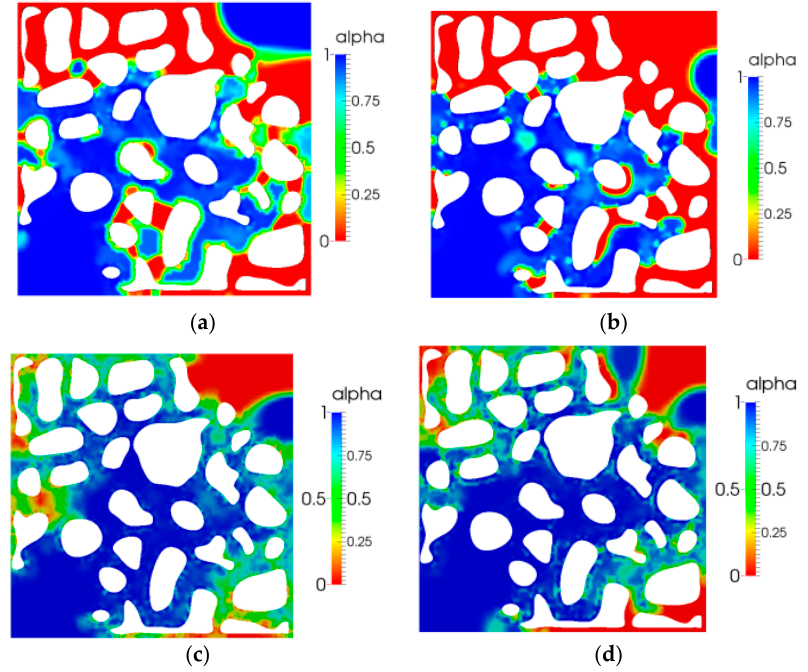
flooding; ( c ) 19 s viscoelastic polymer flooding ( λ = 0.01); and ( d ) 21 s viscoelastic polymer flooding ( λ = 0.03).